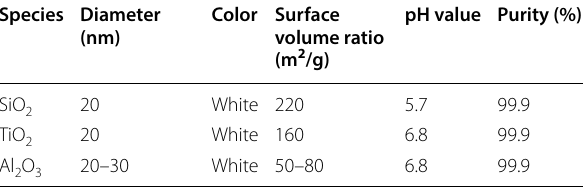
Table 2 Properties of